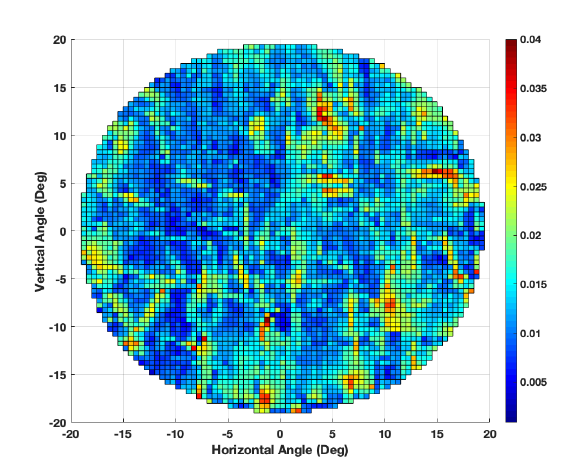
Figure 7. Livox Mid-40 RMSE of Residuals (Color) in meters, plotted as a function of horizontal and vertical angle 3.2 Ouster The Ouster OSI-64 data least squares adjustment contained 24 instrument set-ups and 133 observed planes. The final least squares adjustment considered 413,765 measurements on these planar surfaces. Statistics on the final residuals of the Livox points constrained to the VZ-2000 reference planes are given in Table 3, and plots of these residuals w.r.t. various observables are given in Figure